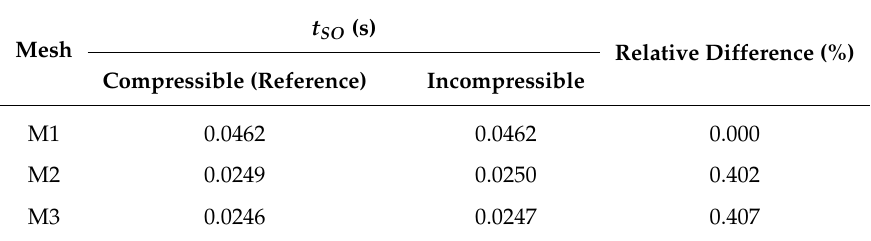
Table 5. Comparison of the switch-over time obtained with the compressible (reference) and incompressible formulations, with the NIC